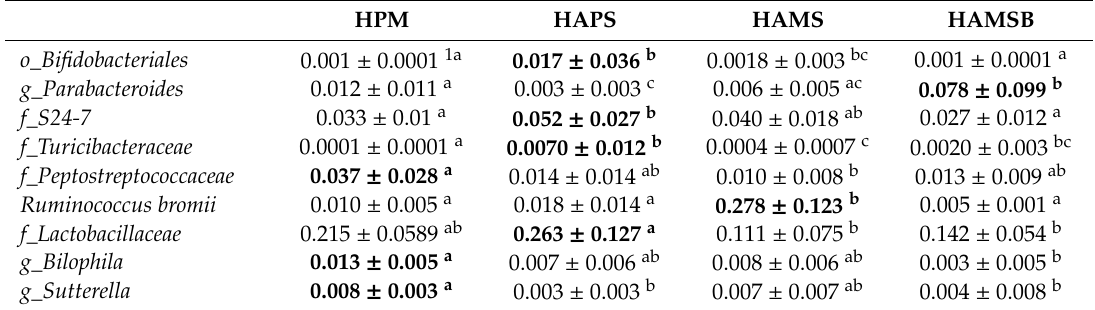
Table 2. Bacterial proportions that di ff ered between rats in a diet-dependent